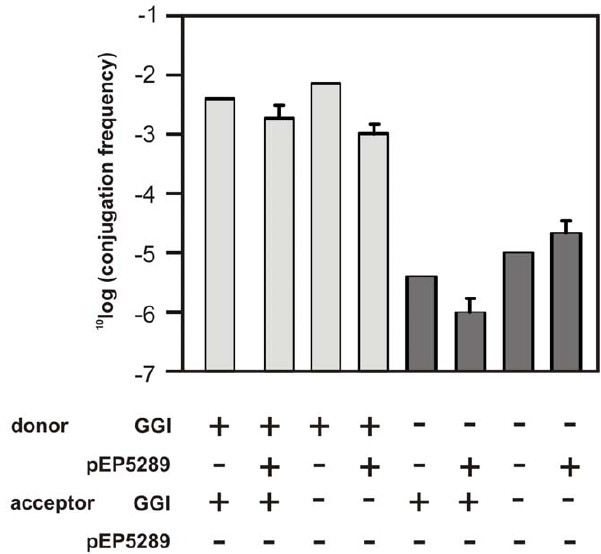
Figure 6. Transfer of chromosomal markers via the Type IV DNA secretion system is not influenced by the presence of the conjugative plasmid. Strains with the GGI (GGI + ) or without the GGI (GGI-) and/or with (pEP5289 + ) or without (pEP5289-) the conjugative plasmid with the Dutch type tetM determinant and the Dutch type backbone were mixed, and grown at 37 u C under 5% CO 2 . Donor strains contained the erythromycin marker in the recA gene, while recipient Neisseria strains contained the chloramphenicol marker. After 5 h of growth, serial dilutions were spread on selective media. Transfer frequencies were calculated as CFU of transconjugants per CFU of donor.